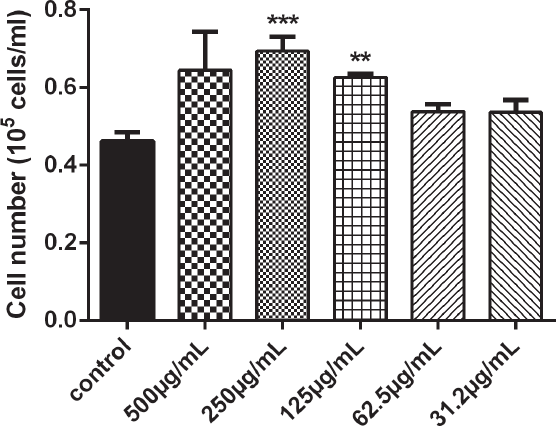
Figure 3 - Effects of EEStb on HEp-2 Cell number *** p<0.001 and **p<0.01 vs control